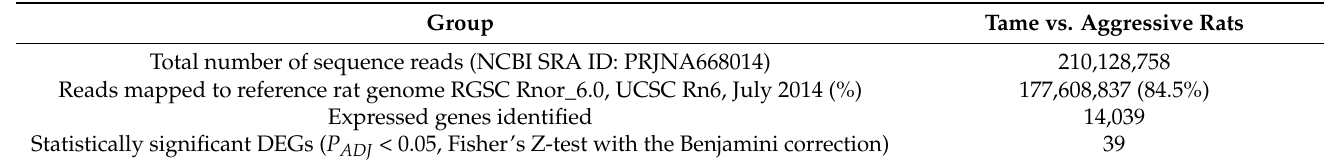
Table 1. A summary of searches for DEGs in the PAG transcriptomes of three tame adult male rats ( R. norvegicus ) and three aggressive adult male rats, all animals being unrelated.